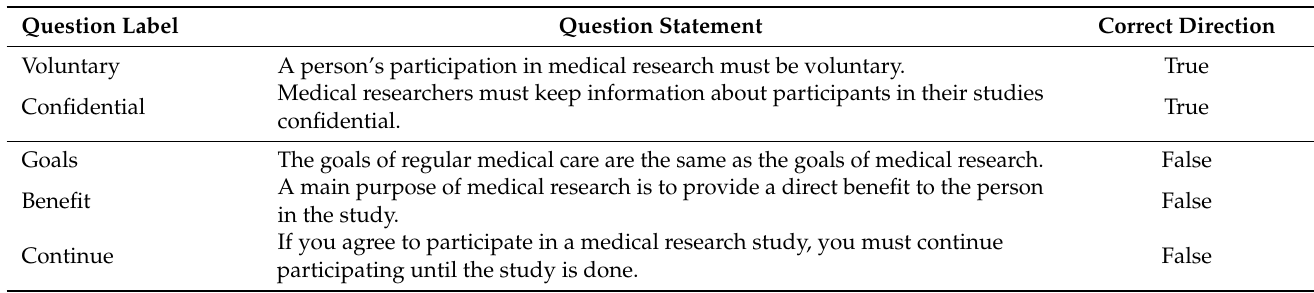
Table 2. Exact Wording of the Medical Research Literacy